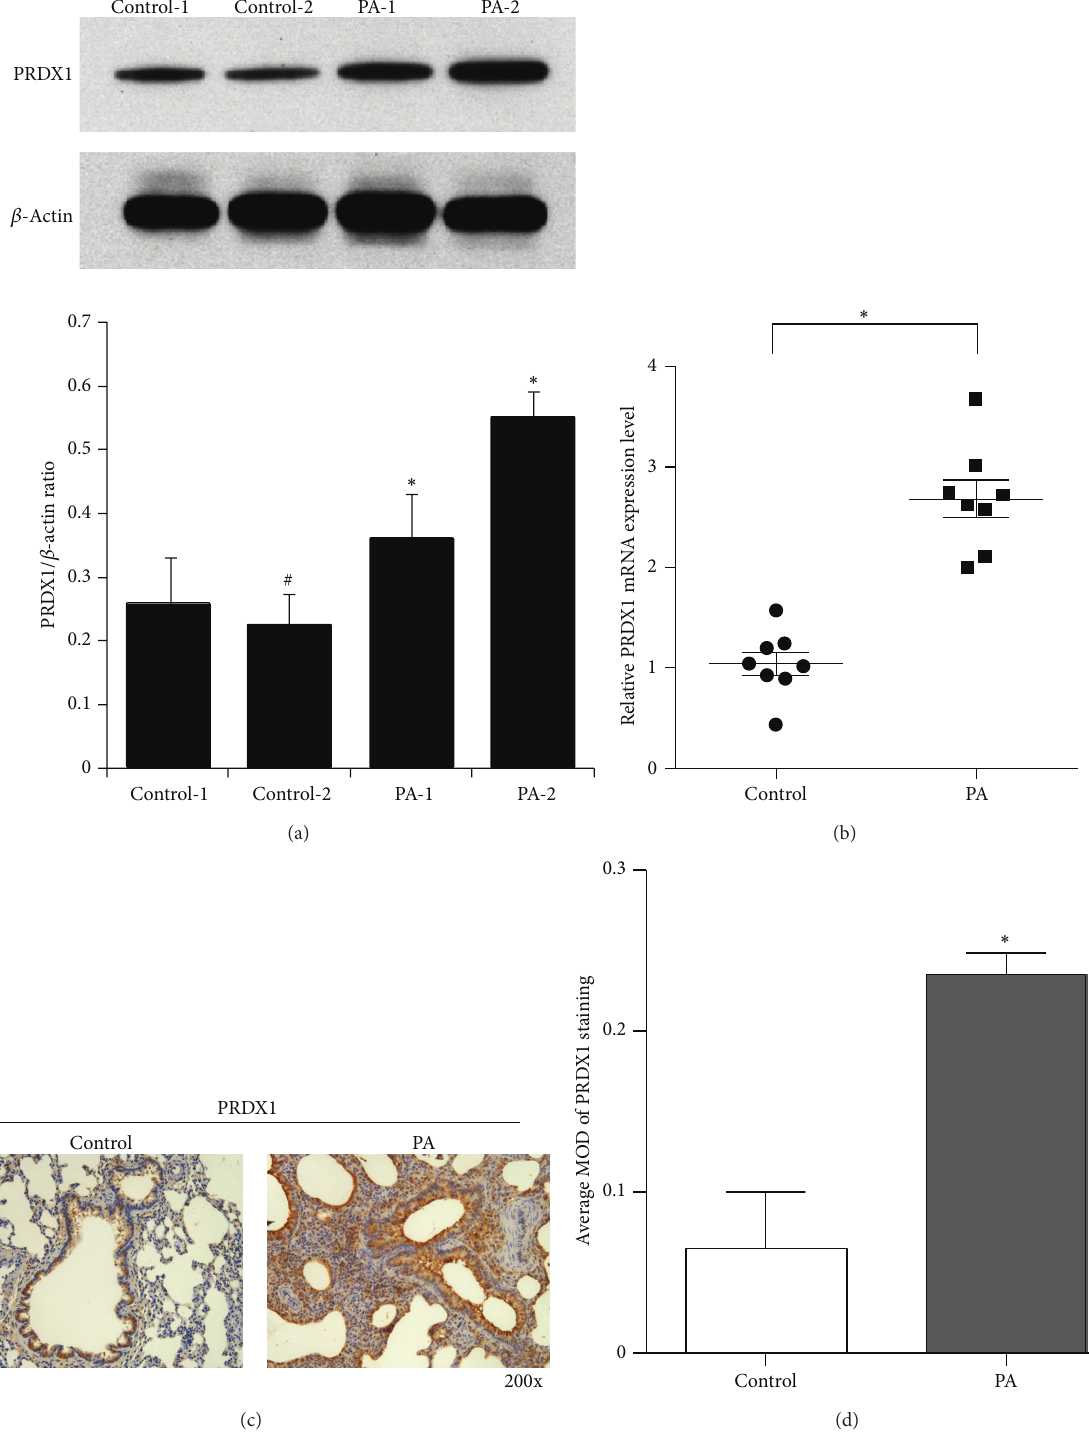
Figure 3: The mRNA and protein level of PRDX1 was determined by western blotting (a), real-time PCR (b), and IHC ((c) and (d)), respectively. (a) Expression of PRDX1 protein in lung tissues of ALI and control rats by western blotting. 𝛽 -Actin was used as a loading control. Data are reported as relative densitometry of the PRDX1 over 𝛽 -actin in bar graphs. There is no statistical significance between Control-2 and Control-1, ∗ 𝑃 < 0.05 versus Control-1. (b) Real-time PCR analysis of PRDX1 mRNA expression in the ALI and control rats. (c) PRDX1 expression levels were upregulated in ALI rat lung tissue in comparison to the control rat lung tissue as examined by IHC, original magnification, × 200. (d) The average MOD of PRDX1 staining between the ALI and control rat lung tissues was statistically quantified. (b) and (d): 𝑛 = 8 rats/group. ∗ 𝑃 < 0.05